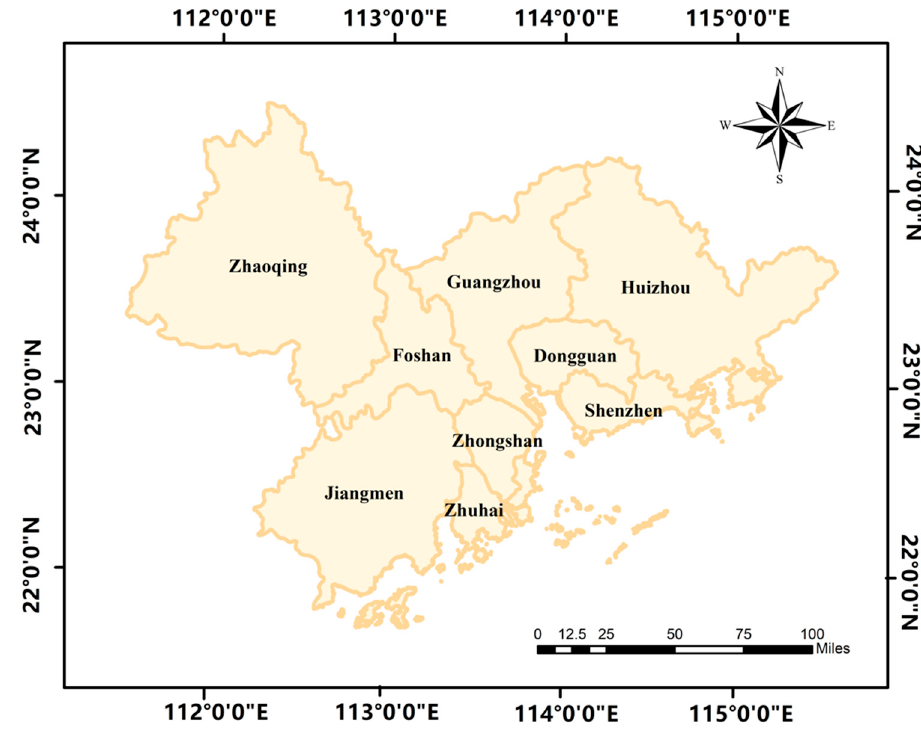
Figure 1. The study area location.